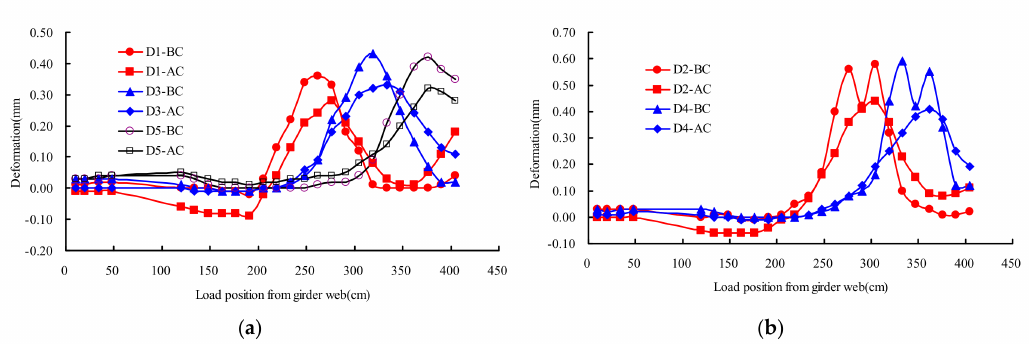
Figure 16. Deflections of deck plate under transverse wheel positions: ( a ) M1 and M2; ( b ) M3 and